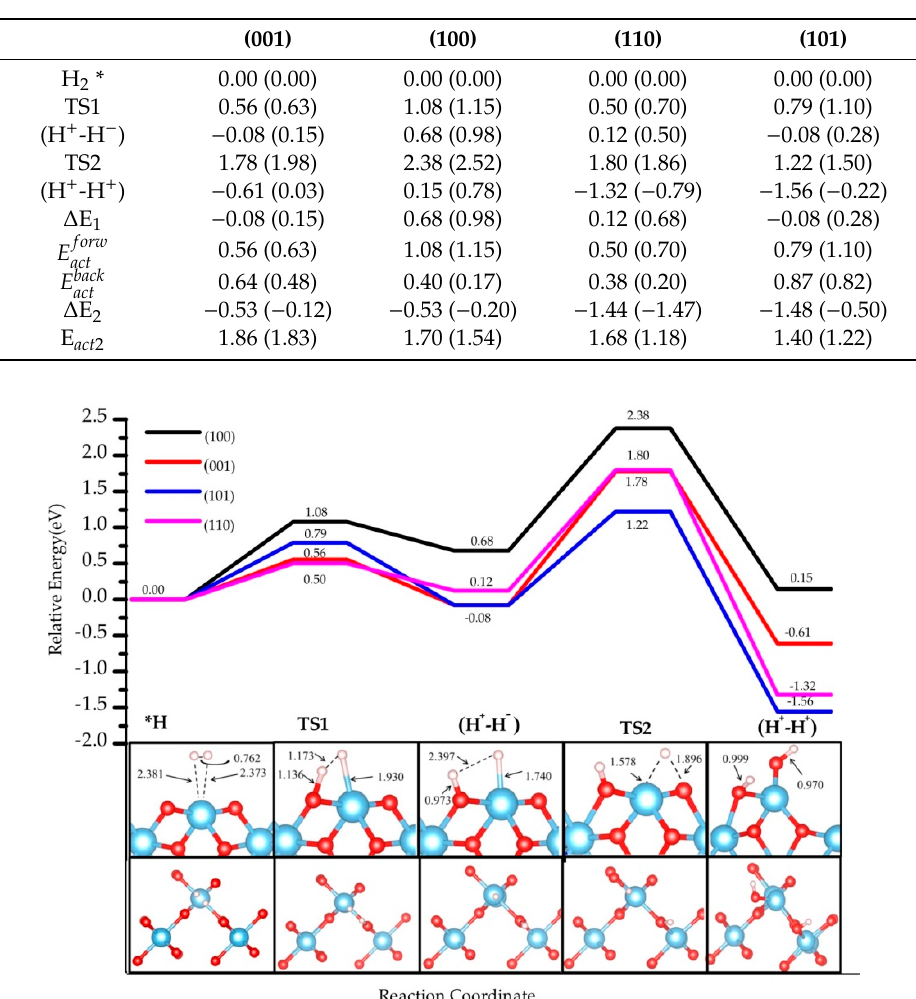
Table 2. Reaction energy ( ∆ E), dissociation activation energy ( E forw ), and backward activation energies ( E back eV) for step 1, and the H transfer barrier of step 2 (E act 2 ). Values in brackets are energies without U correction (see below and Supplementary Information). All energies are referred to the physisorbed TiO 2 -H 2 system. * indicates adsorption state.